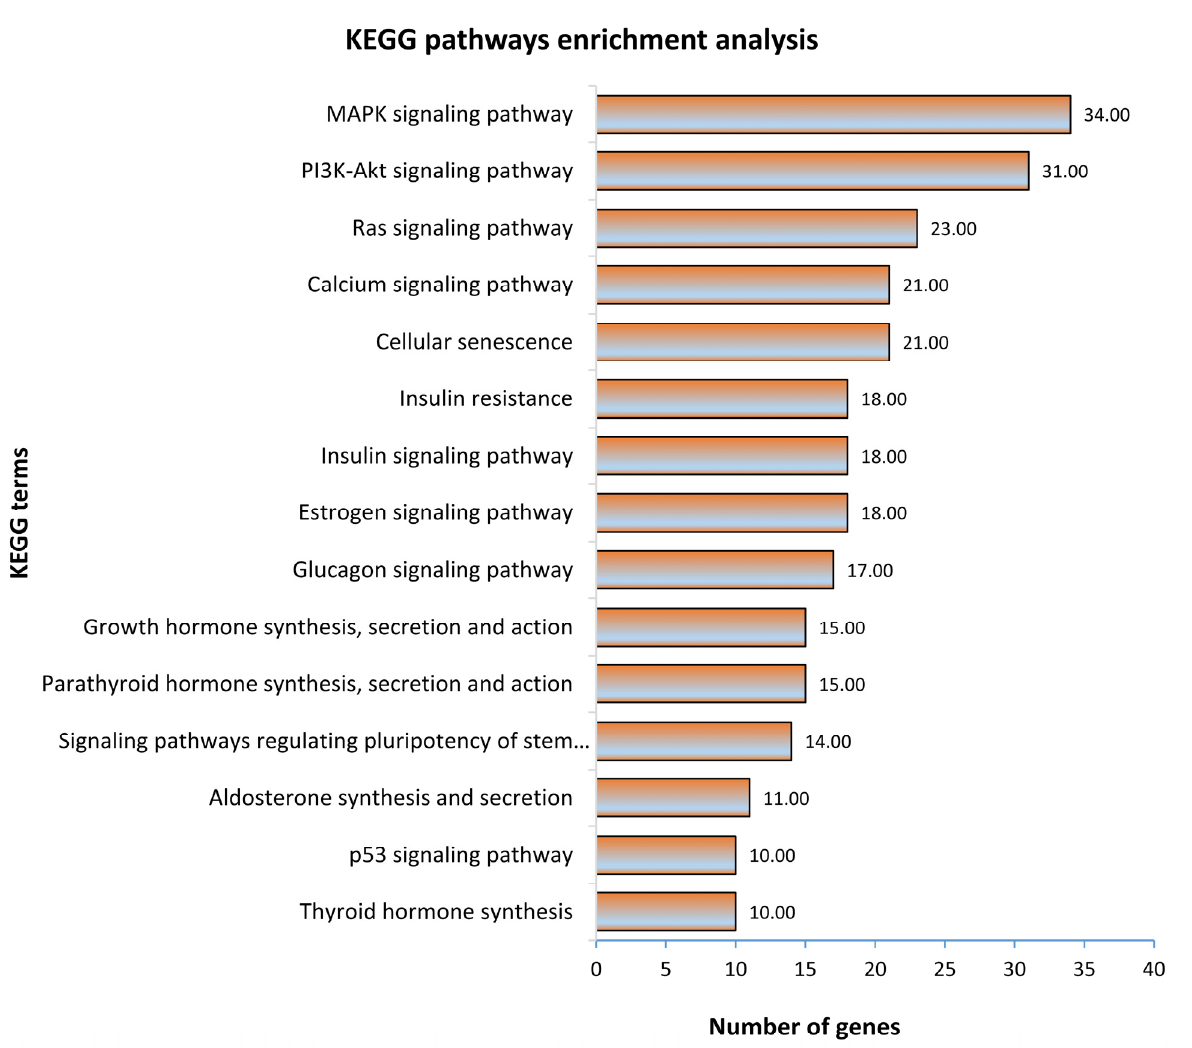
Figure 3. KEGG pathway enrichment analysis of genes significantly correlated to fetal weight at 63 dpc. KEGG pathways with a p ≤ 0.05 were considered significantly enriched. A complete list of KEGG pathways significantly enriched by fetal weight-correlated genes is provided in Table S5.